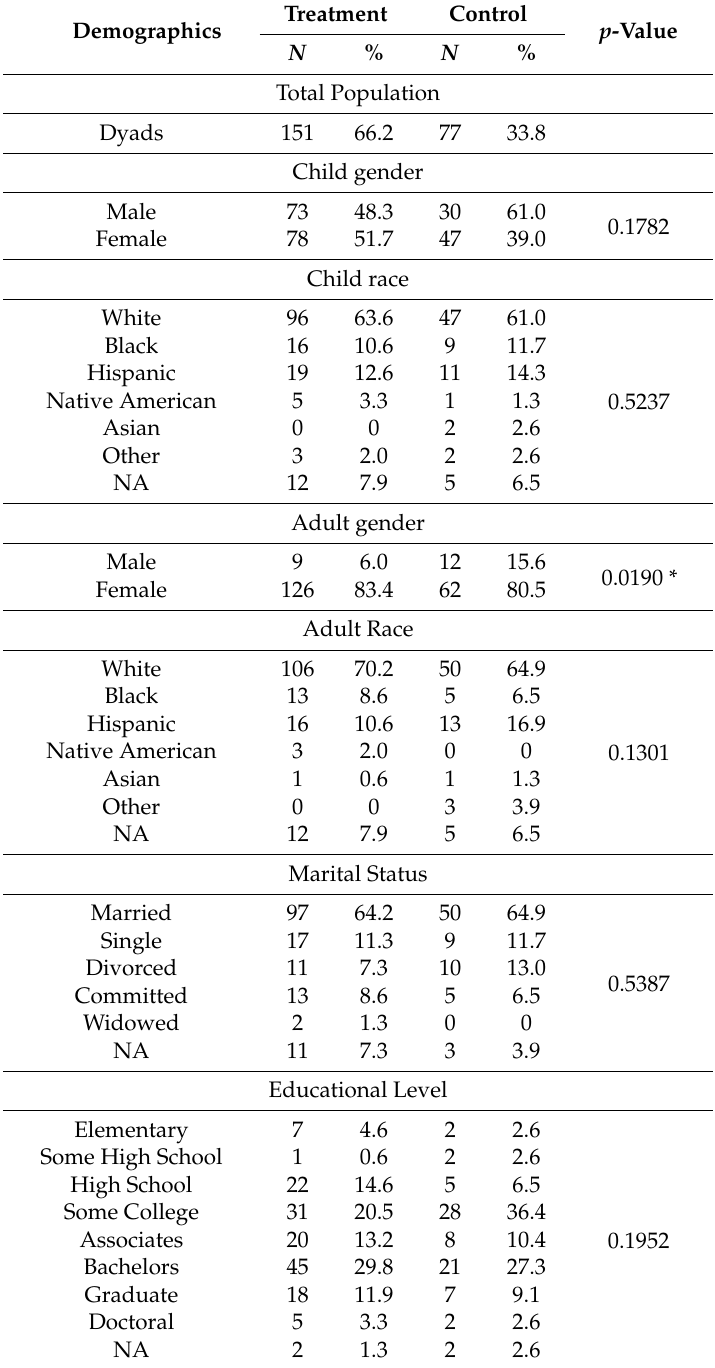
Table 1. Baseline demographics of children and adults enrolled in the iCook 4-H